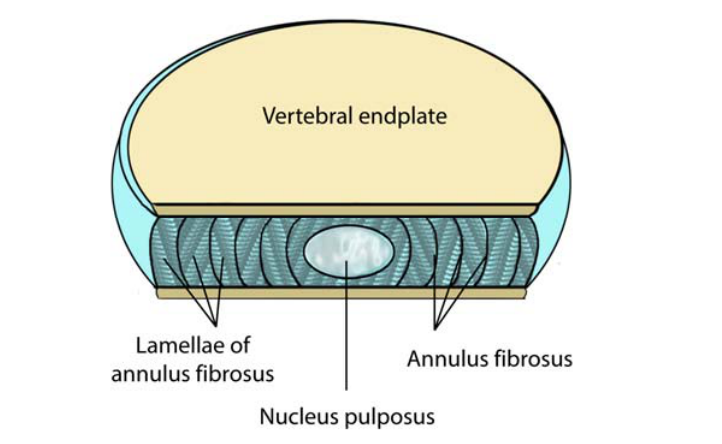
Figure 1. A sectional view of a normal lumbar disc. Note the locations of the nucleus pulposus, the vertebral end plate and the annulus fibrosus. The intervertebral lumbar disc is typically 4cm wide and 7-10 mm thick (adapted from Raj et al. [34]). The interior of the disc including the nucleus pulposus is